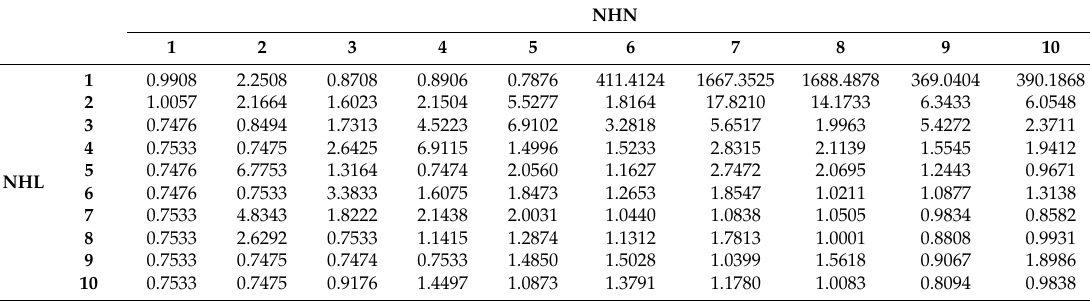
Table 6. RMSE between the simulated and predicted values for various NHN and